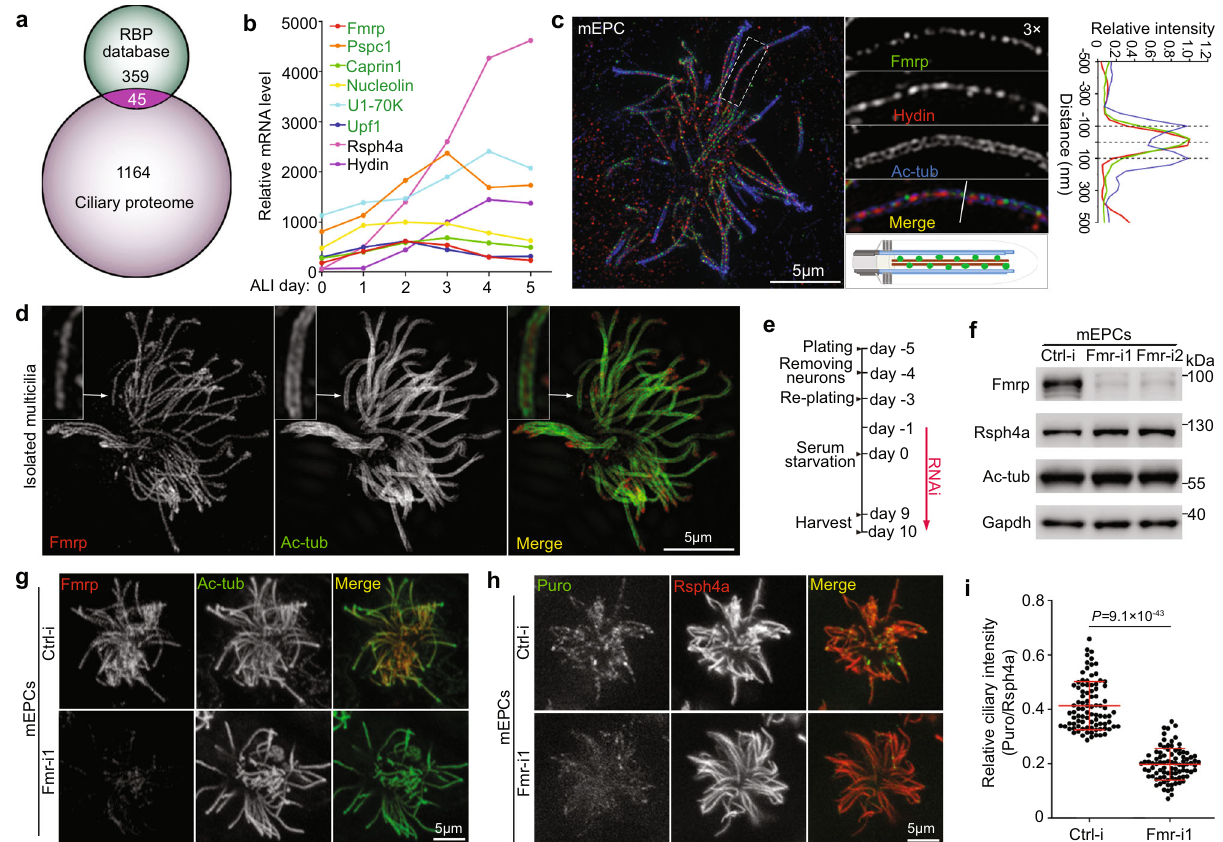
Fig. 4 Fmrp is enriched in the central lumen and important for local translation of ependymal cilia. a Venn Diagram showing overlapping proteins between our cilia proteome and an RBP database. Protein hits with ≥ 5 unique peptides in the proteome were used for comparison. b Gene expression patterns of the indicated RBPs (green) during multiciliation. Data were from our previous cDNA array results of mTECs 40 . Rsph4a and Hydin were used to show expression patterns of typical motile cilia-related genes. c Fmrp was enriched in the ciliary central lumen as puncta. Day-10 mEPCs were imaged with 3D-SIM. Ac-tub and Hydin labelled axonemes and central pairs, respectively. A typical cilium was magni fi ed to show details. Line scan at the indicated region of the magni fi ed inset shows colocalization of Fmrp with Hydin. The diagram depicts the central lumen localization of Fmrp. d Representative 3D- SIM images of isolated day-10 ependymal multicilia showing central lumen distribution of punctate Fmrp. e Experimental scheme for RNAi in mEPCs. mEPCs were transfected with a control siRNA (Ctrl-i) and two siRNAs against Fmr1 (Fmr-i1, -i2) and collected at day 10 for immunoblotting ( f ) and immunostaining ( g ) or day 9 for Puro labeling ( h ). As multicilia formation occurs from after day 3, this protocol is expected to deplete Fmrp prior to multiciliation. f Ef fi cient depletion of Fmrp. Gapdh served as loading control. The levels of Rsph4a and Ac-tub were used to re fl ect ef fi ciencies of multiciliated cell differentiation and multicilia formation, respectively. g Confocal images showing depletion of Fmrp markedly reduced the ciliary IF signals of Fmrp. h, i Depletion of Fmrp impaired ciliary local protein translation. mEPCs transfected with Ctrl-i or Fmr-i1 were subjected to Puro labeling (see Fig. 3a) at day 9. Rsph4a served as ciliary marker in confocal imaging ( h ). Quanti fi cation results ( i ) were pooled from three independent experiments. 30 multiciliated mEPCs were measured in each experiment and condition. For each cell, the total ciliary IF intensity of Puro was normalized to that of Rsph4a. The bars and errors represent mean ± s.d. Two-tailed student ’ s t